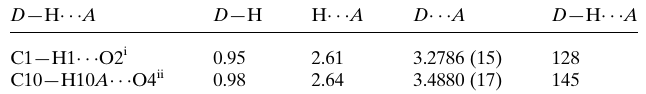
Table 1 Hydrogen-bond geometry (A˚ , (cid:2)